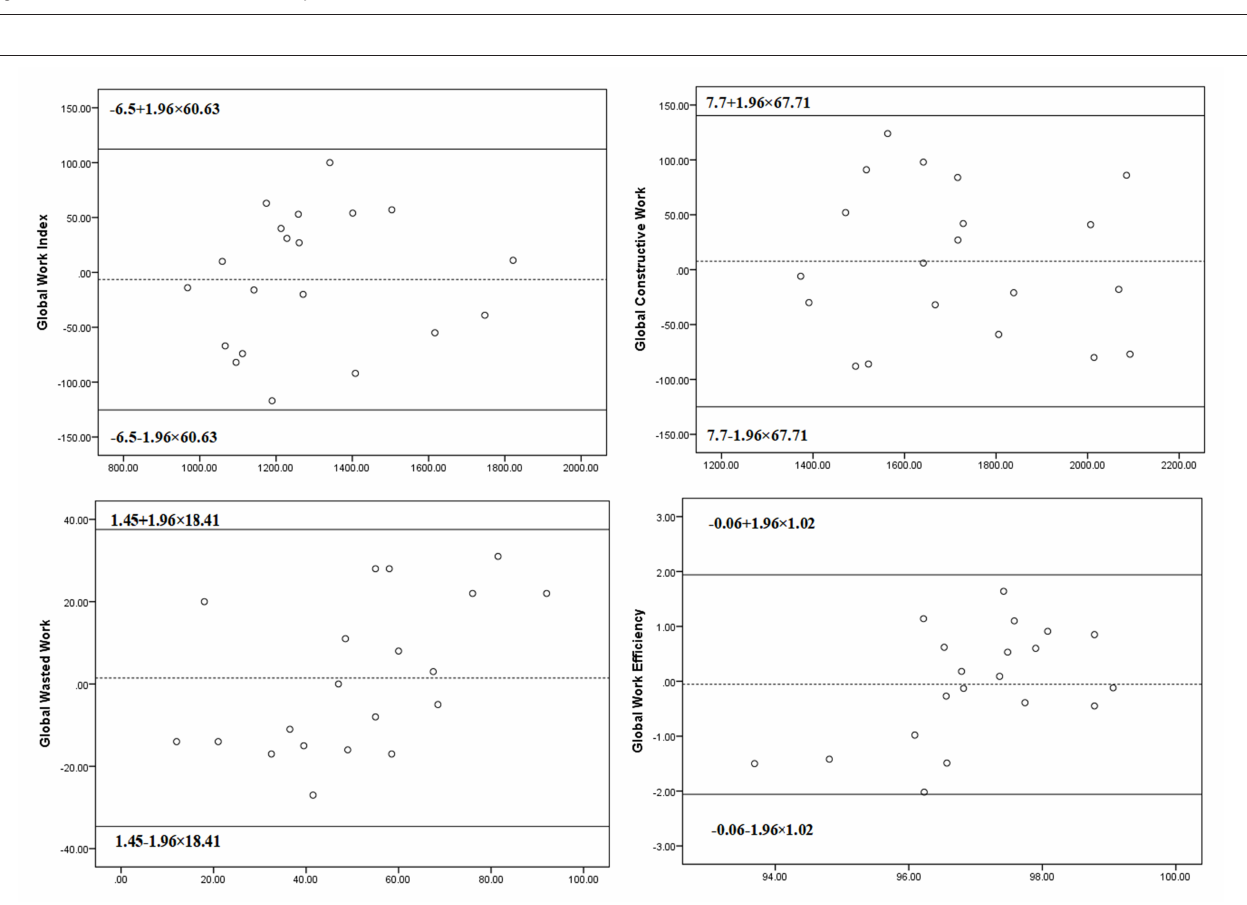
Hg% (95% CI: 1,582–2,881), respectively. The reference ranges of GWW and GWE were 78.5 (53–122.2) mm Hg% and 96